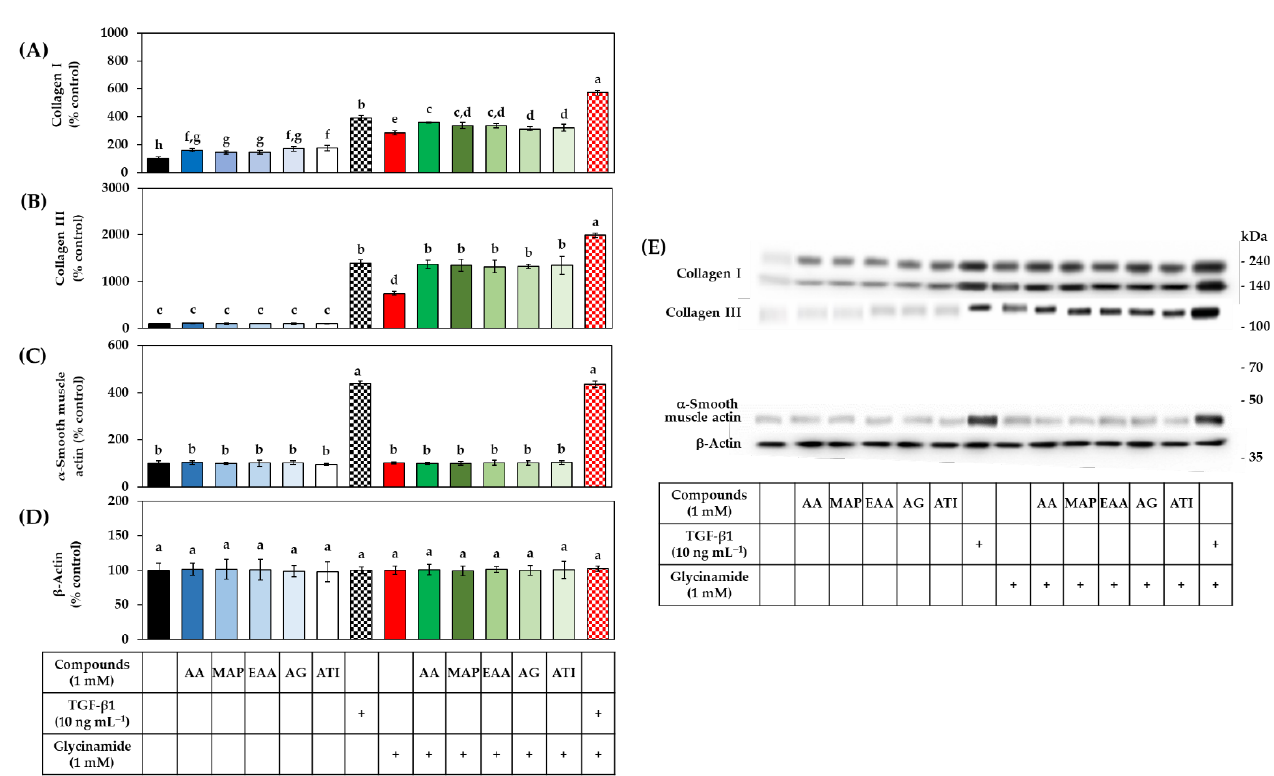
Figure 11. Effects of individual and combined treatments of AA analogs (such as AA, MAP, EAA, AG, and ATI), glycinamide, and TGF- β1 on the protein levels of collagen I, III, α -smooth muscle actin, and β -actin in HDFs. Cells were treated with an AA analog or TGF- β1 in the absence or presence of glycinamide for 24 h. The intracellular levels of collagen I ( A ), collagen III ( B ), α -smooth muscle actin ( C ), and β -actin ( D ) were analyzed by Western blot. A reconstituted image of typical blots is shown with molecular weight markers ( E ). Data are presented as % of control (means ± SD, n = 3). Groups that share the same alphabet letters (a – h) do not have significantly different means at the p < 0.05 level.